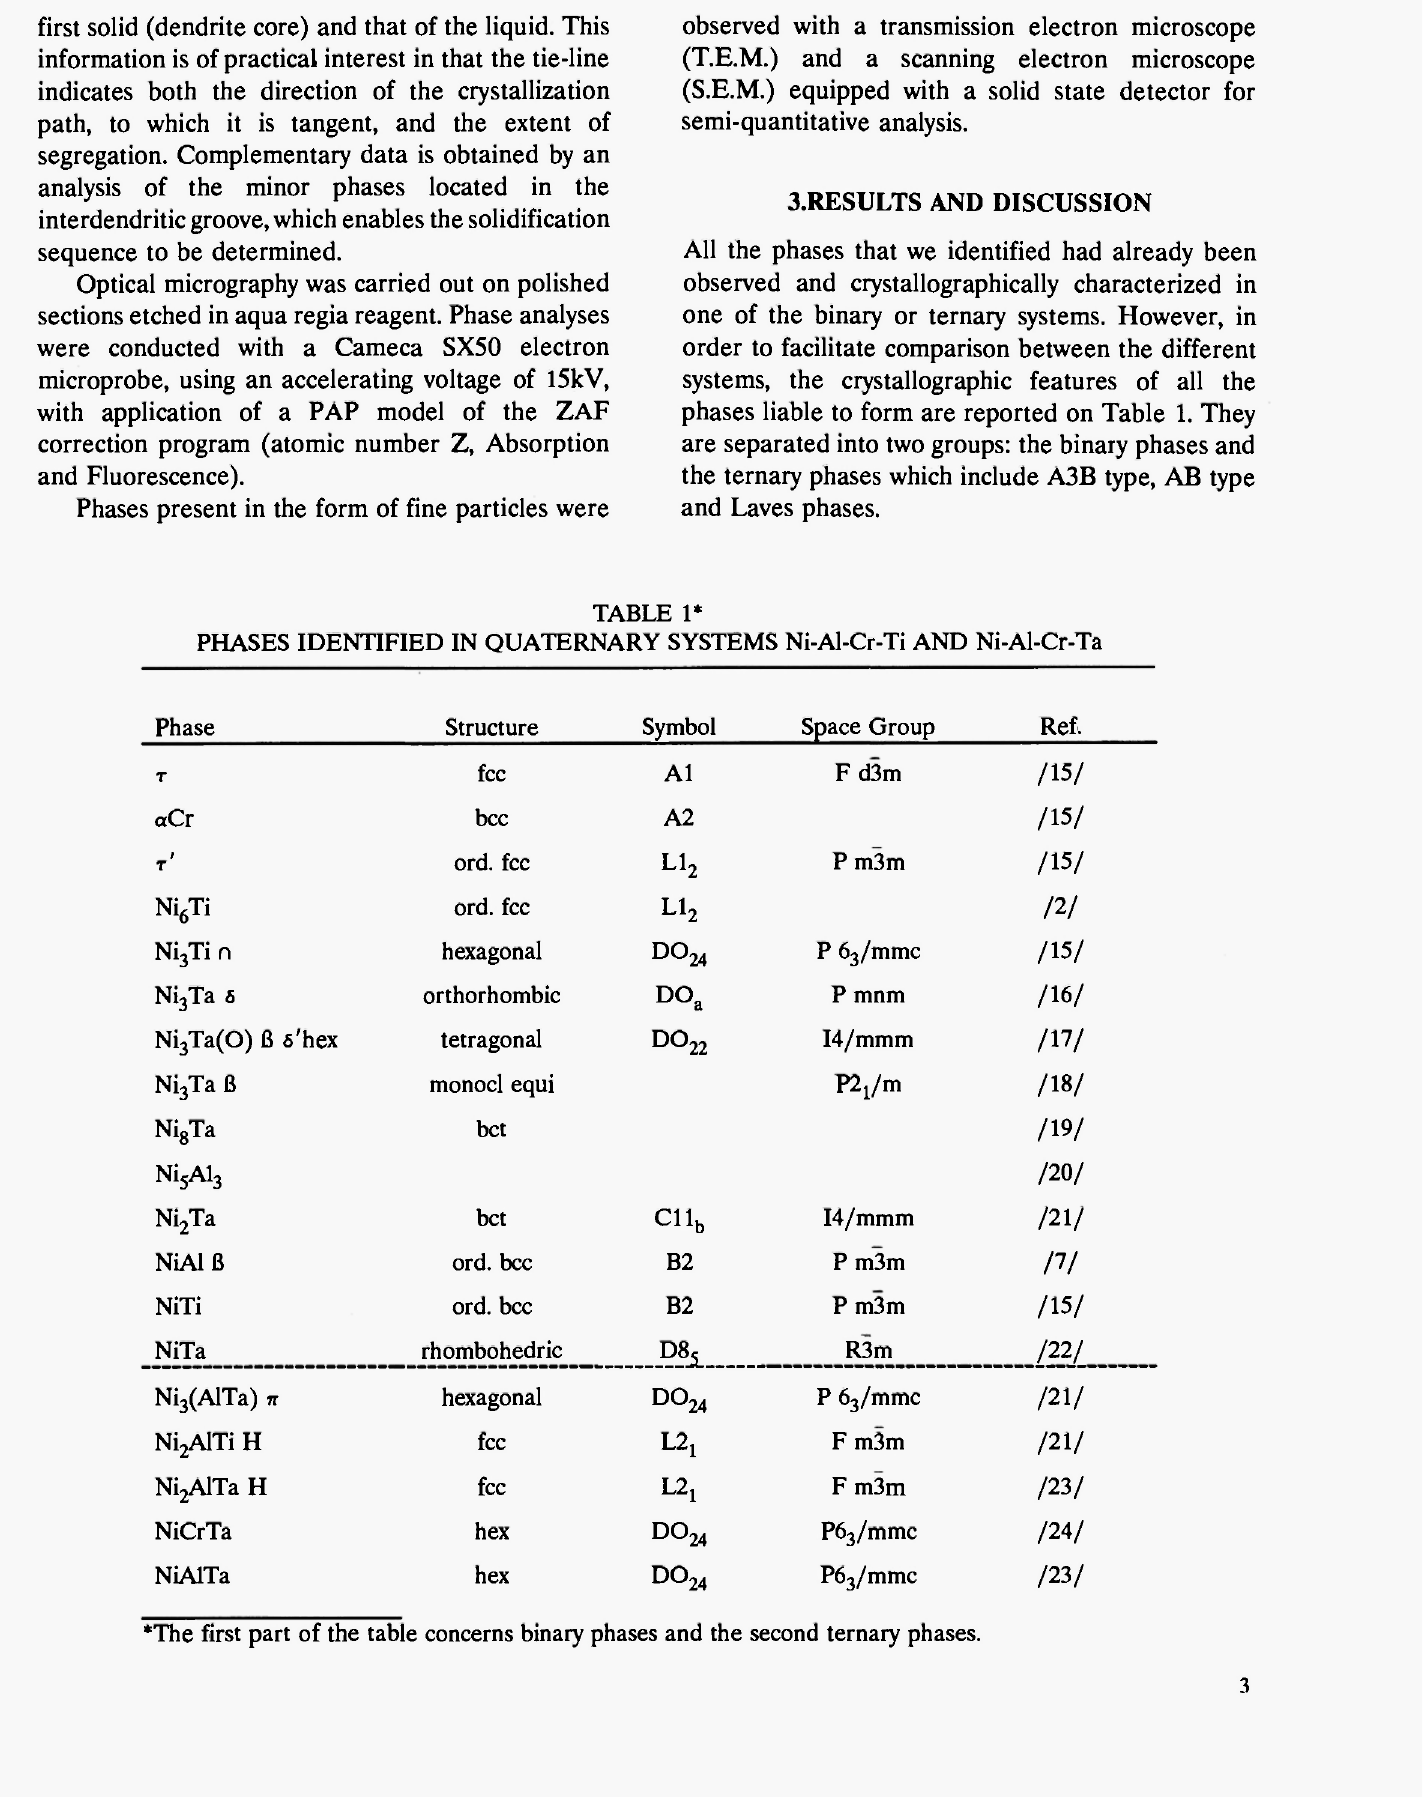
Phase Structure